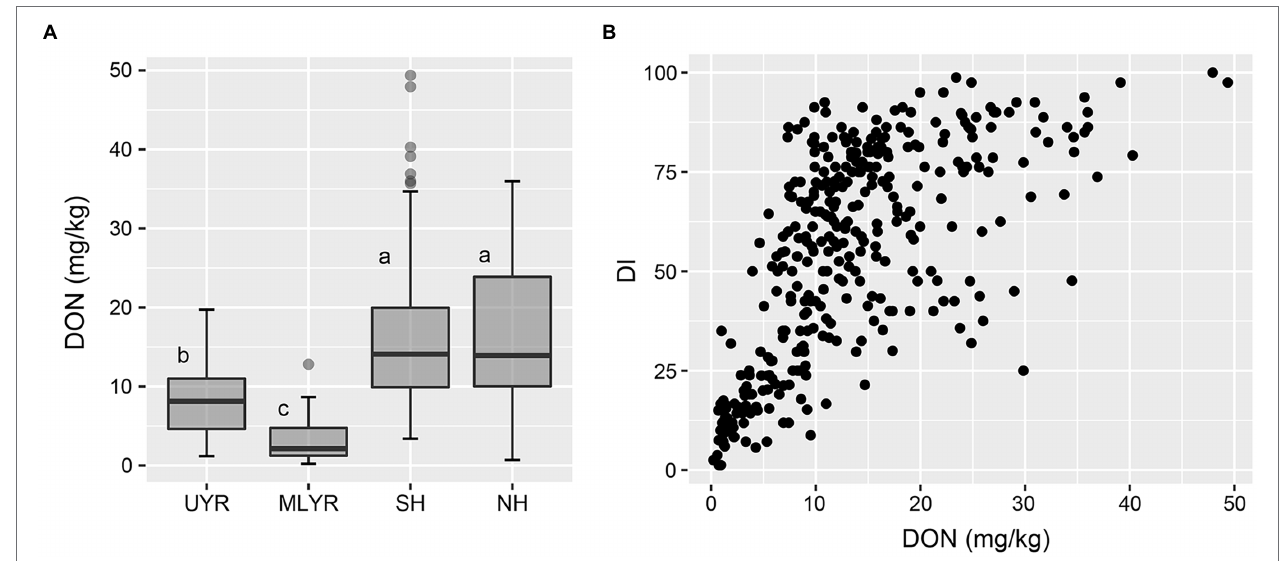
FIGURE 5 | DON accumulation level of wheat cultivars from four ecology regions (A) and the correlation between DI and DON content (B) in the Yangzhou nursery.